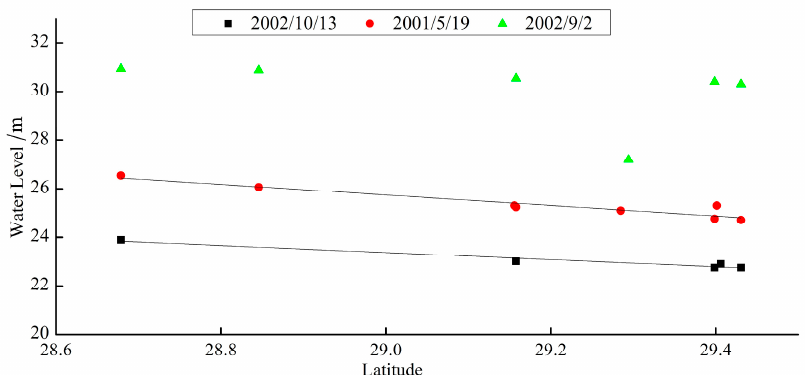
Figure 11. Relationship between latitude and water level in low-flow period, normal-flow period, and high-flow period.